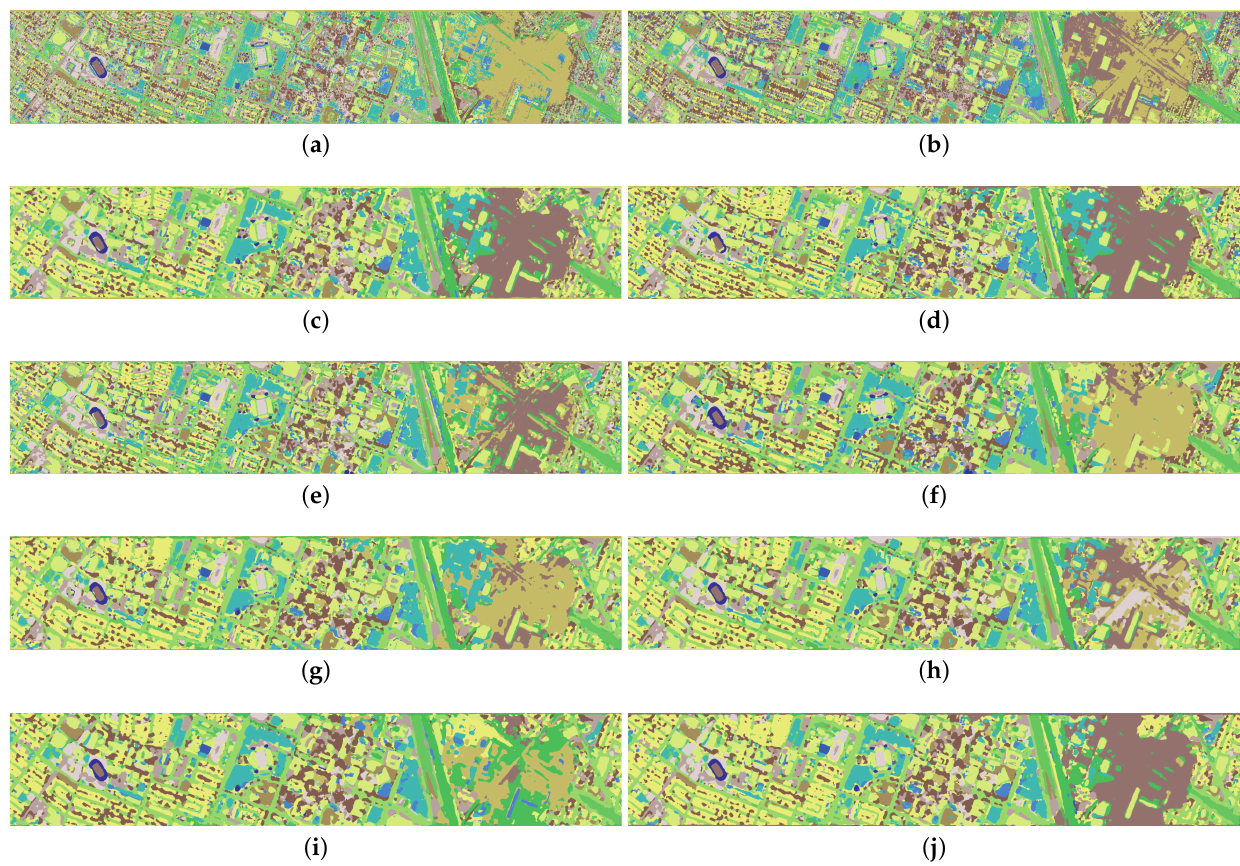
Figure 14. Classification maps for the UH dataset. ( a ) SVM (OA = 79.5%). ( b ) EMP (OA = 83.3%). ( c ) DenseNet (OA = 83.2%). ( d ) DPRN (OA = 82.5%). ( e ) FDMFN (OA = 84.3%). ( f ) MSRN (OA = 85.9%). ( g ) LWRN (OA = 84.4%).